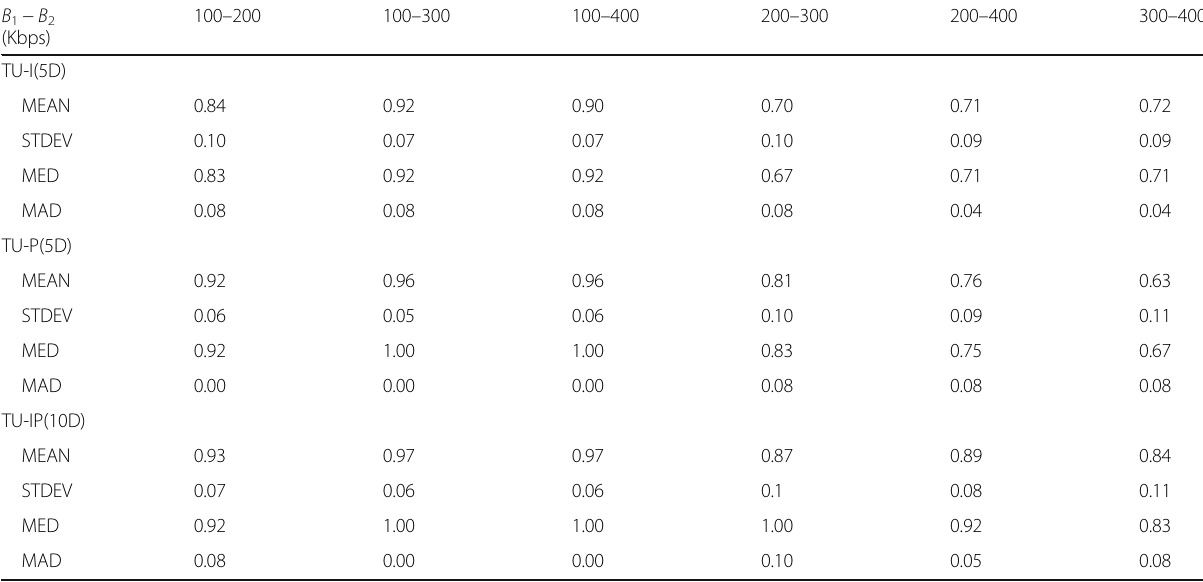
Table 2 Detection accuracy of the double compressed video fragments from its corresponding single compressed ones using TU-I, TU-P, and TU features on QCIF video dataset B 1 − B 2